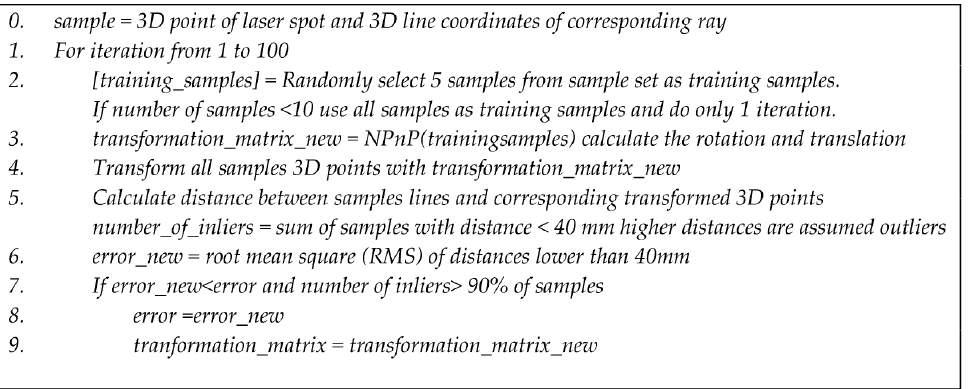
Figure 4. Example of calibration setup. The laser rays are described in the laser galvanometer coordinate system. The laser spots are detected and described in the 3D range camera coordinate system.